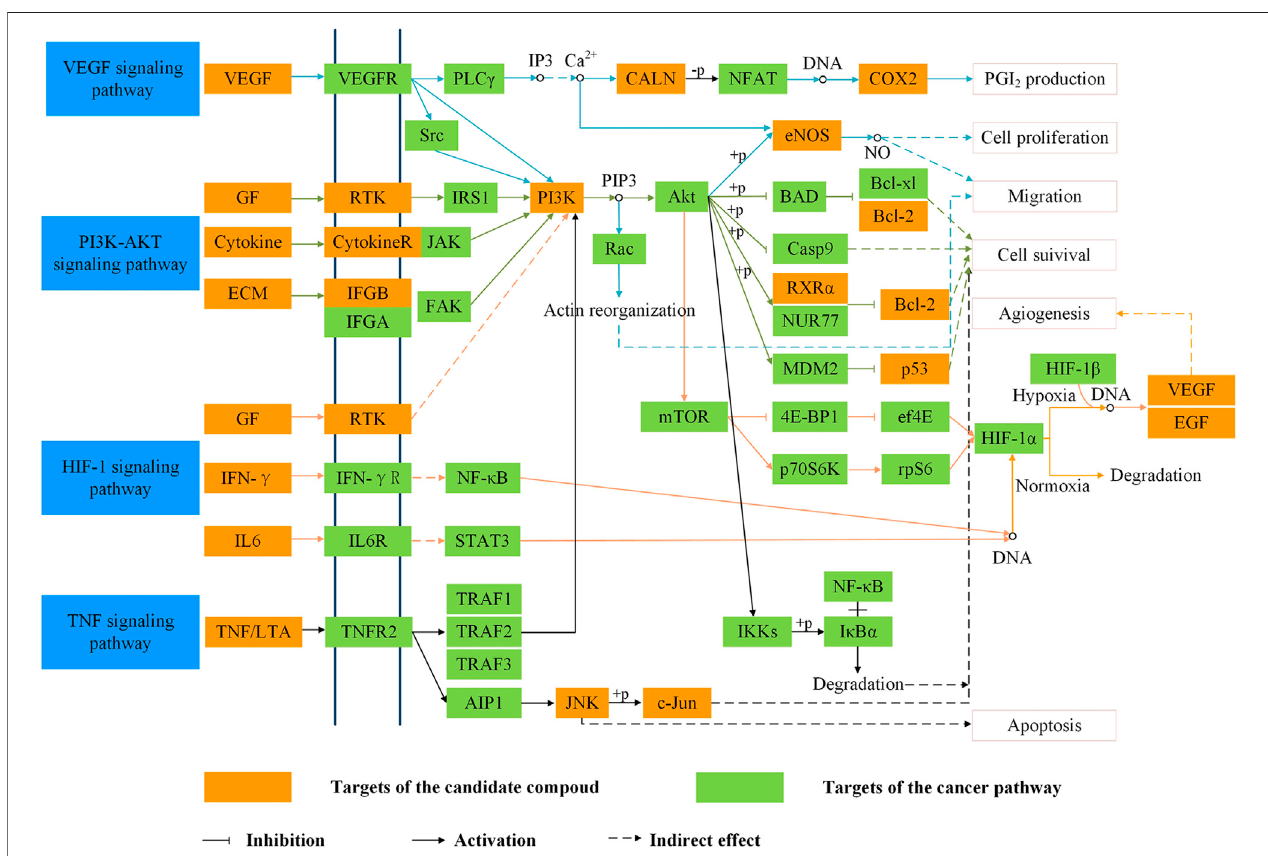
FIGURE7| Representativecancerpathwayandtherapeuticmodulesof Saussureainvolucrata. Thearrowstandsfortheactivationeffect,thet-arrowstandsforthe inhibition effect, and the dotted line represents indirectly activation active or inhibition active.